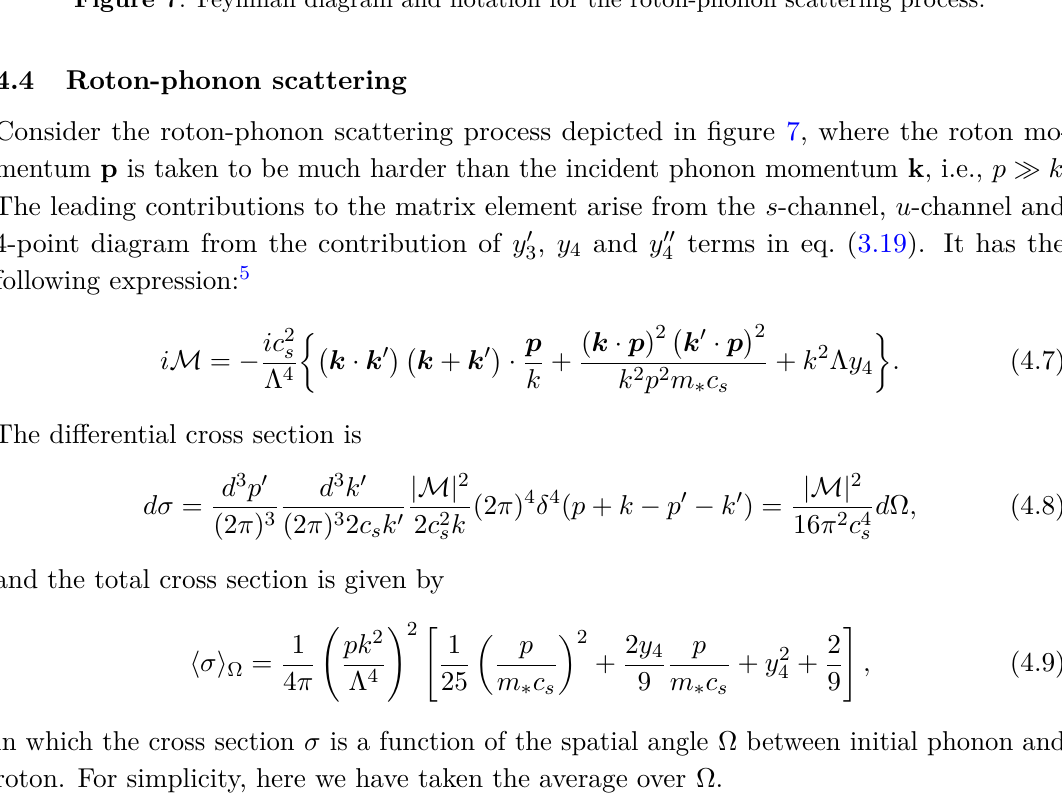
Figure 7 . Feynman diagram and notation for the roton-phonon scattering